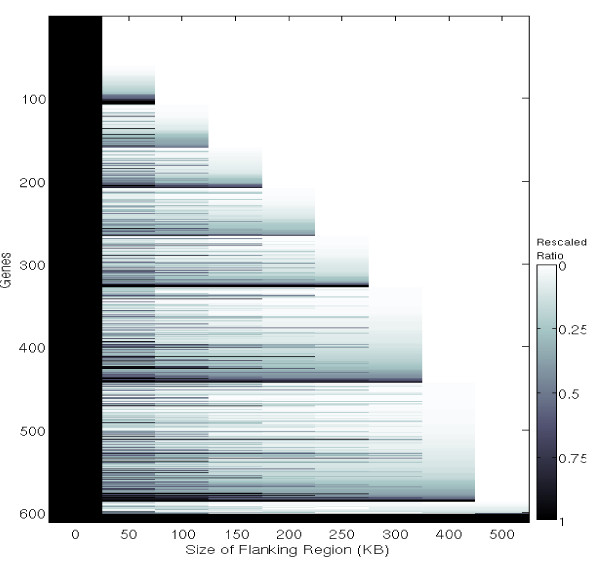
Plot of rescaled objective function value versus the flanking region size. The prediction models for the set of 611 genes selected were built using nine different flanking region sizes, shown on x axis. The y axis shows the list of genes (name not shown). For each gene g, the objective function value Og is rescaled as (Og-min(Og))/(max(Og)-min(Og)). The change of this rescaled ratio for different flanking sizes is plotted on row g using the color lightness as shown in the color bar.